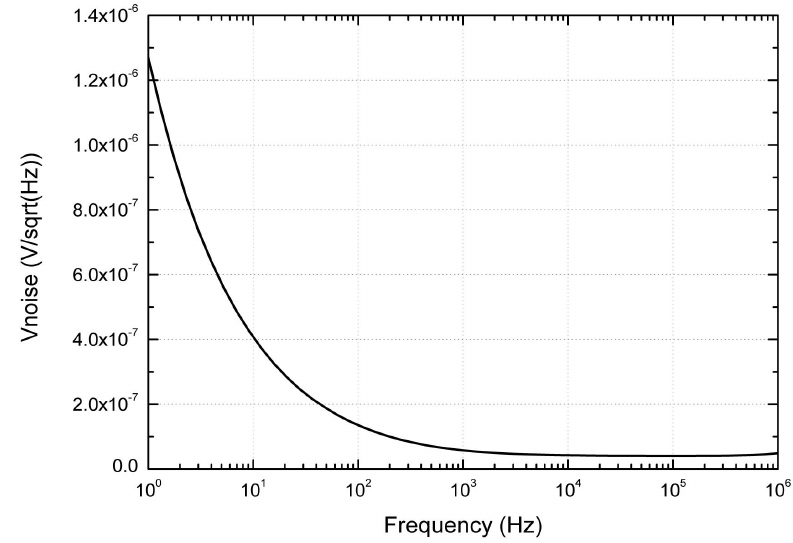
Figure 5. Differential integrator circuit.